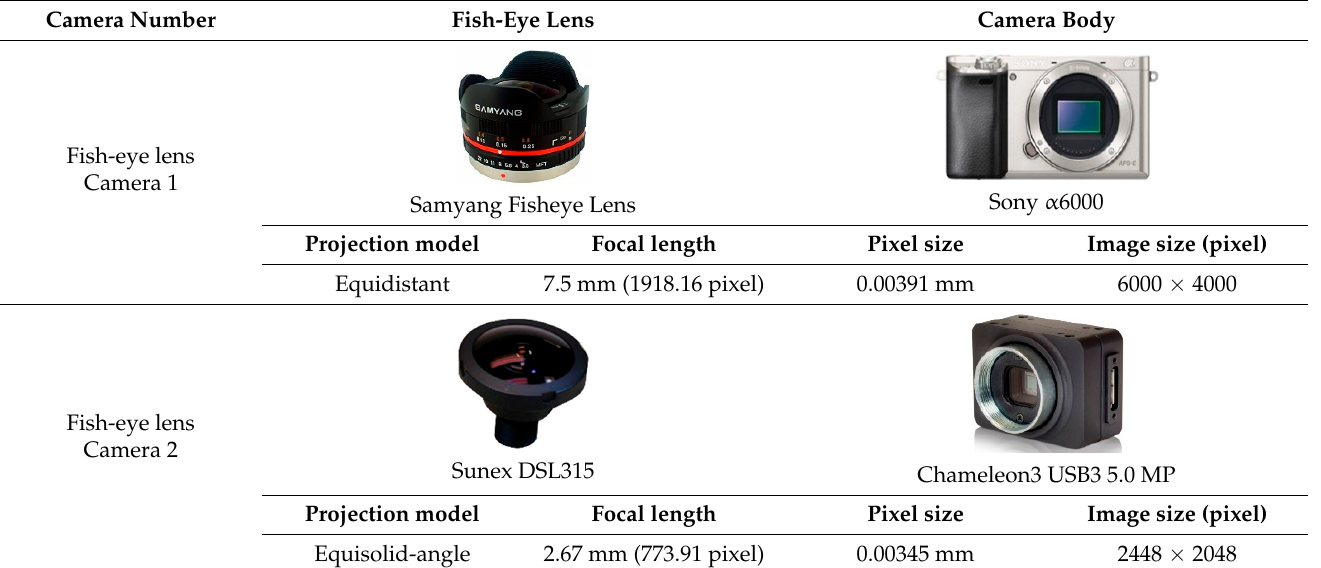
Table 3. Specification of camera in real experiments.